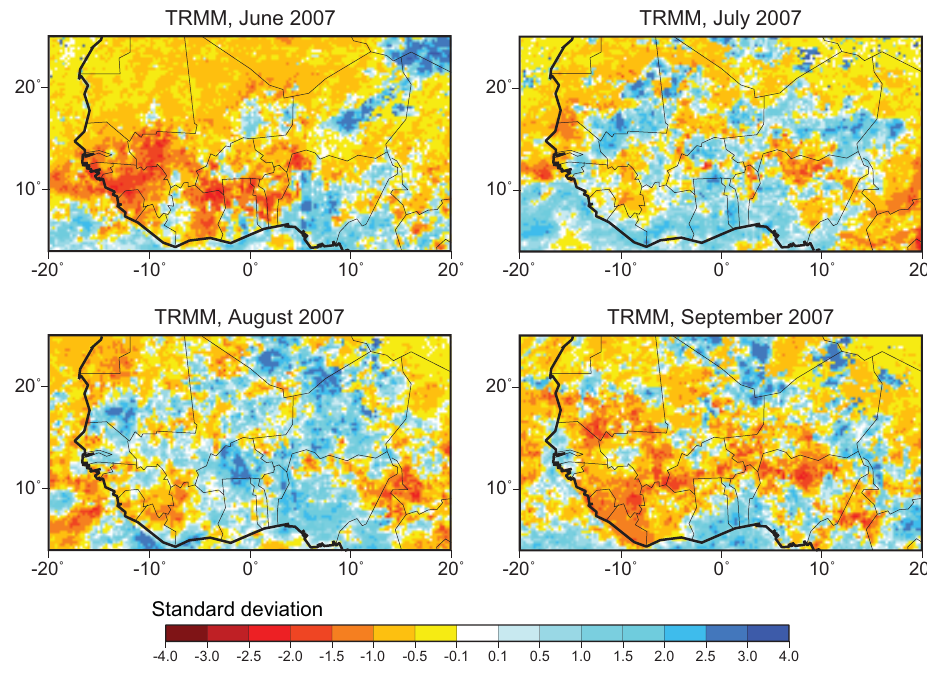
Fig. 2. Standardized precipitation anomalies from the 1998–2007 (based on Paeth et al., 2011).